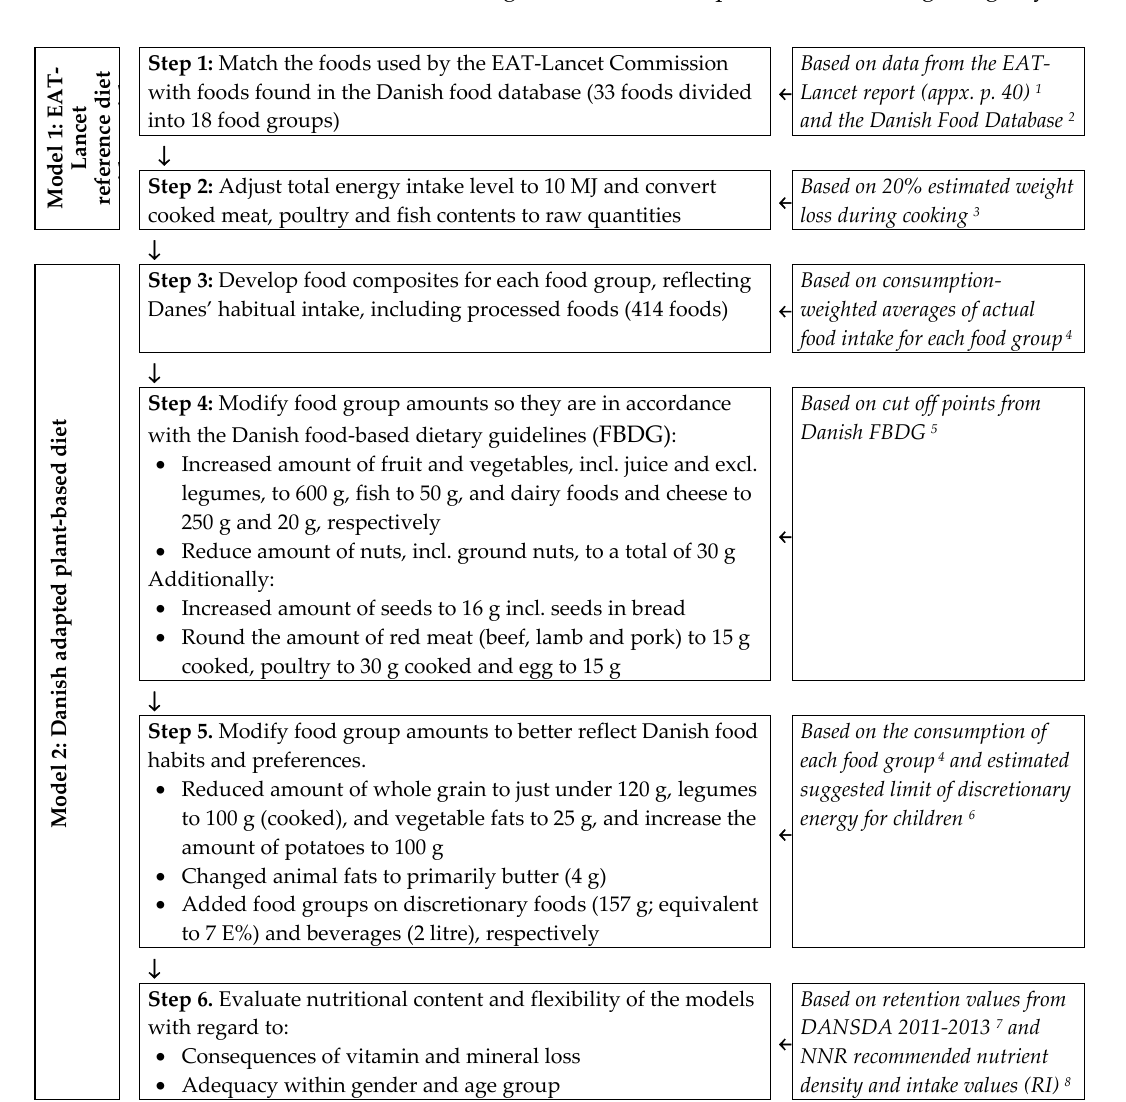
Figure 1. Overview of the steps used in the development of the Danish adapted plant-based diet based on the EAT-Lancet reference diet. 1 [7], 2 [39], 3 [43], 4 Extract from The Danish National Survey of Diet